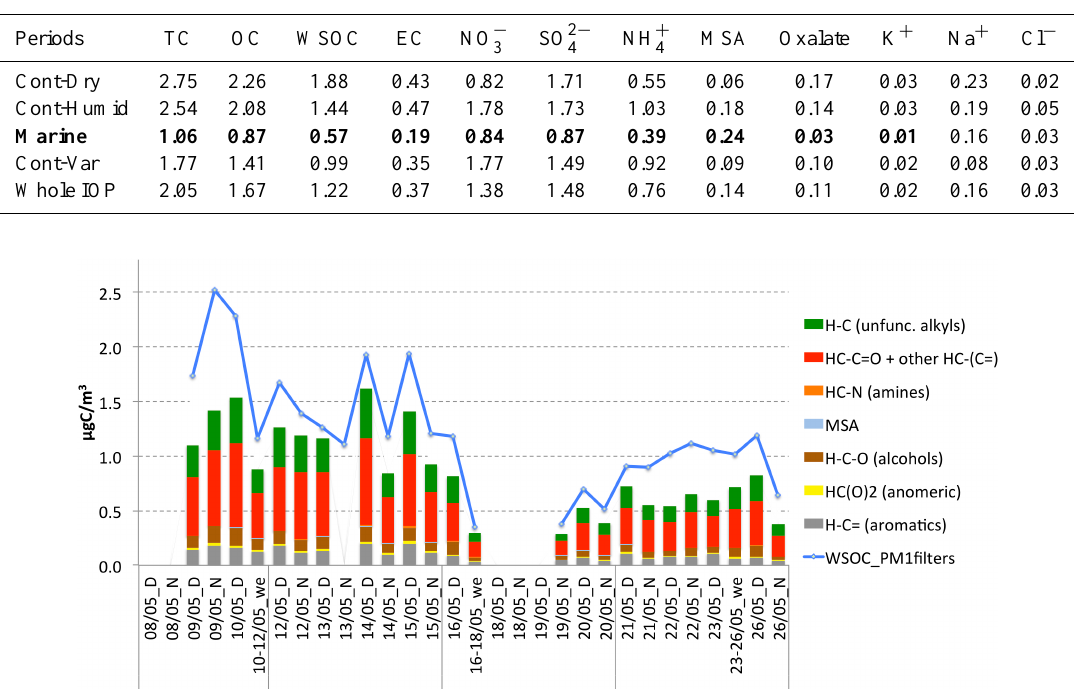
Table 2. Average concentrations (µgCm − 3 for carbon measurements and µgm − 3 for the inorganic ions) of main chemical species in PM 1 filters during the four periods of the campaign. Boldface numbers highlight the main differences in concentrations during the Marine period.